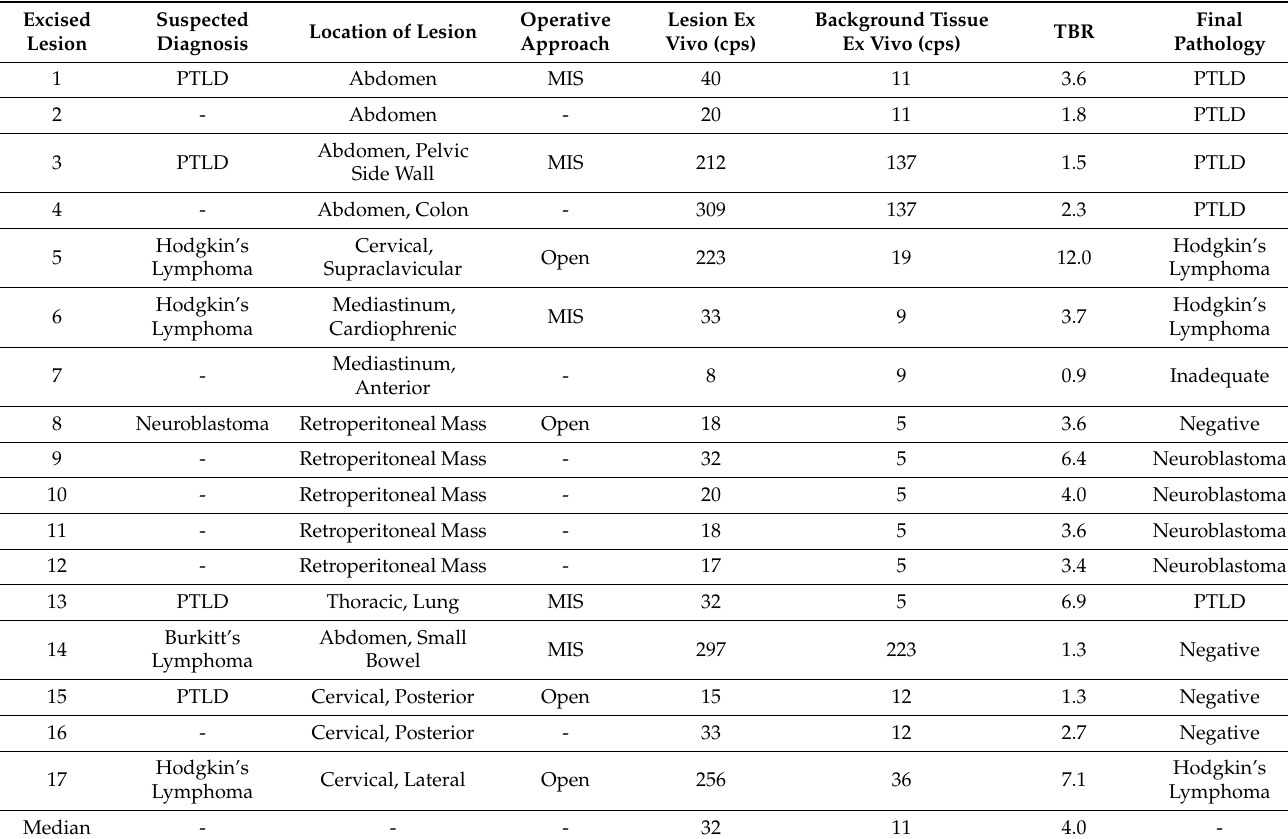
Table 4. Prospective PET probe data from nine pediatric cancer